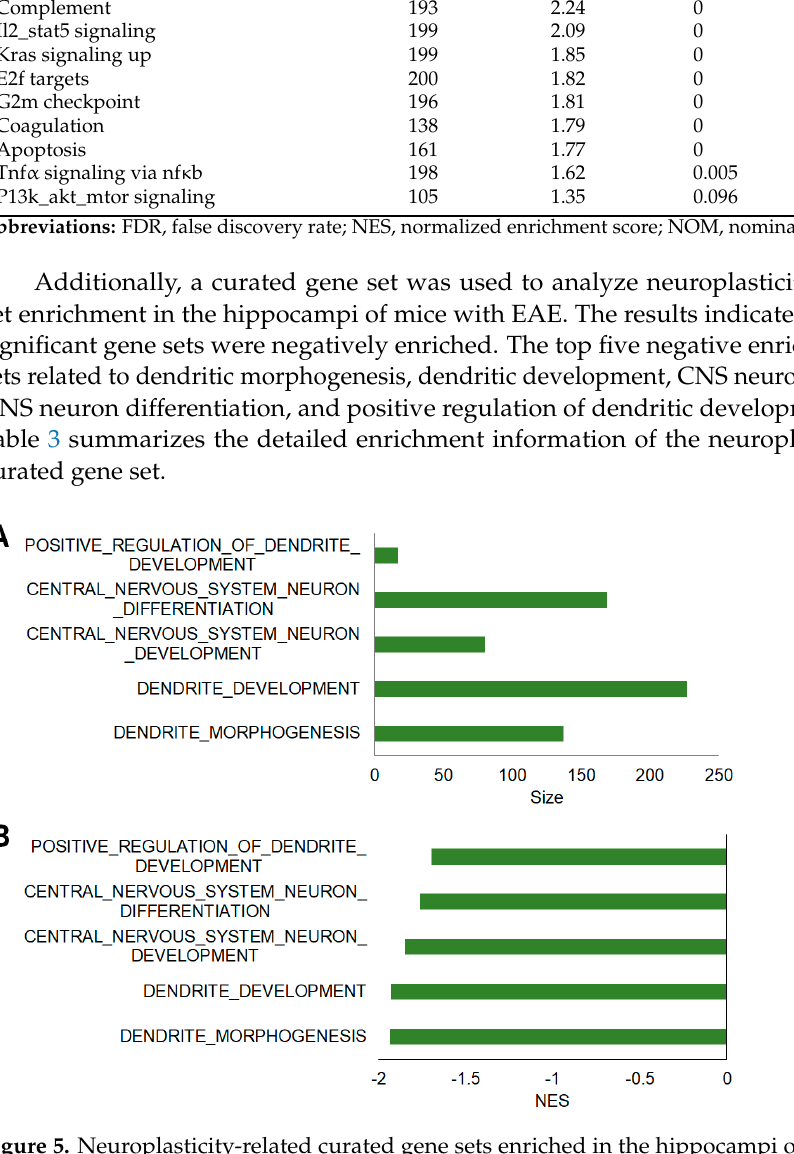
Figure 5. Neuroplasticity-related curated gene sets enriched in the hippocampi of mice with EAE. The bar graphs show the top five gene sets (FDR q -value < 0.25, NOM p -value < 0.05) that were negatively enriched in the EAE-affected group. The bars are ordered by the size of the gene set ( A ) and the normalized enrichment score (NES) indicates the strength of the enrichment ( B ). Table 3. Gene Set Enrichment Analysis (GSEA) results according to the MSigDB neuroplasticity- related curated gene sets.